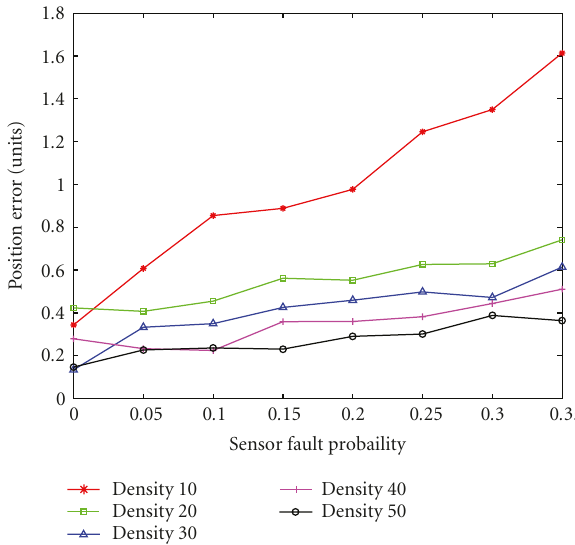
Figure 5: Position error versus p with di ff erent network densities when three targets are deployed. In this scenario, T = 9.